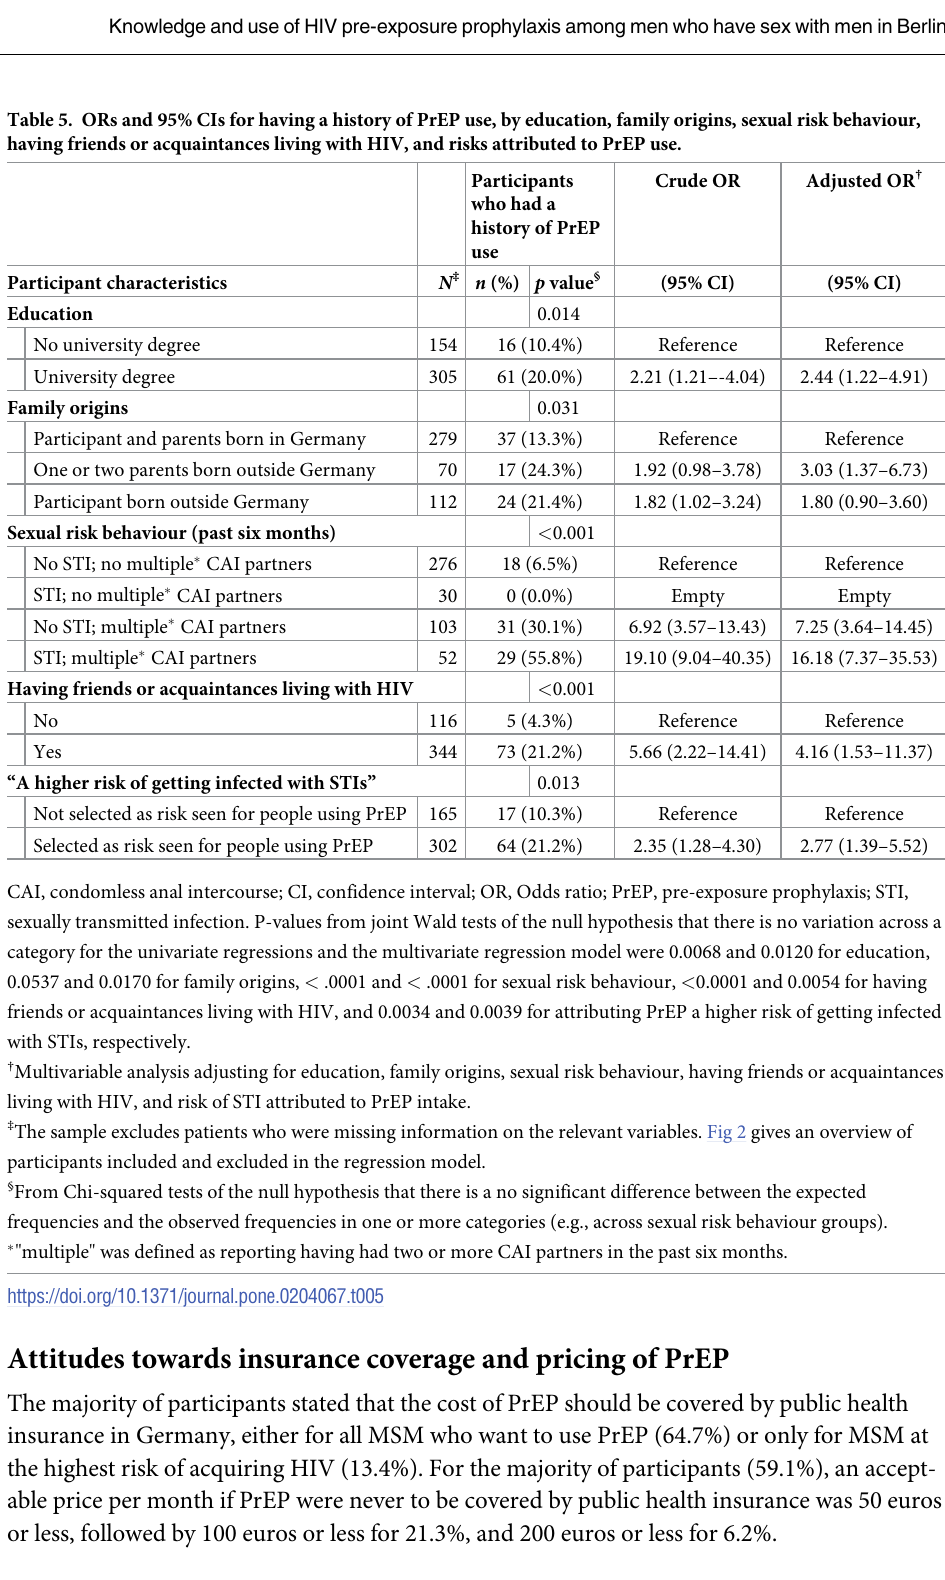
Table 5. ORs and 95% CIs for having a history of PrEP use, by education, family origins, sexual risk behaviour, having friends or acquaintances living with HIV, and risks attributed to PrEP use. Participant